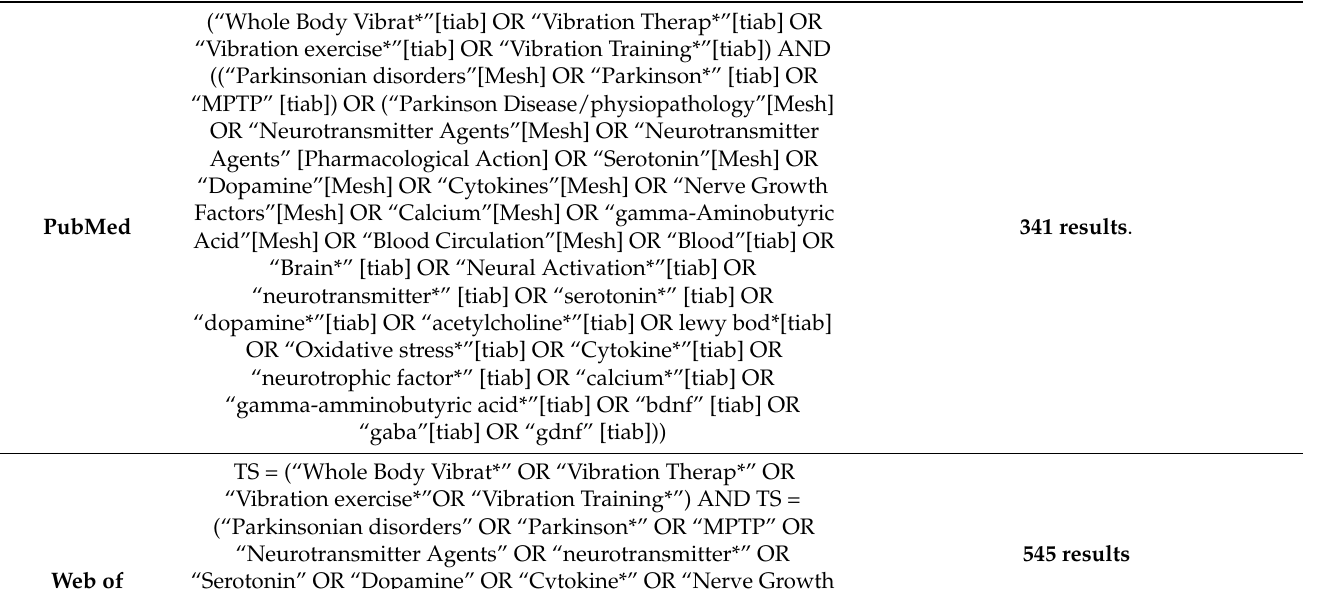
Table A1. Search strategy for each